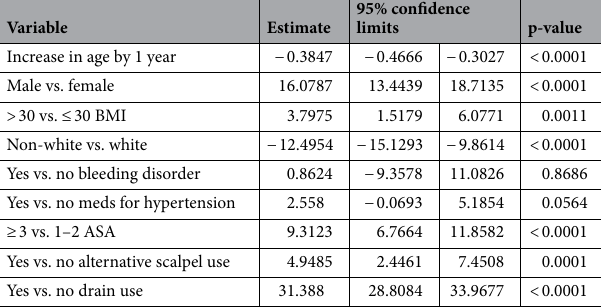
Table 6. Results of multivariate analysis for factors affecting operative